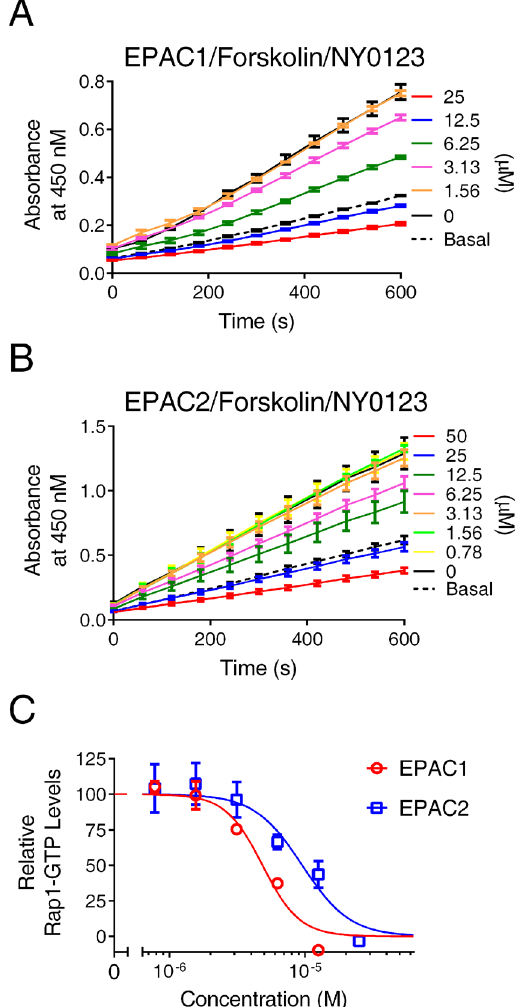
Figure 5. Dose-dependent inhibition of forskolin-induced cellular EPAC1 and EPAC2 activation by NY-0123. ( A ) Time course of EPAC1-mediated Rap1 activation induced by 1 µ M Forskolin in the presence of various concentrations of NY-0123. ( B ) Time course of EPAC2-mediated Rap1 activation induced by 1 µ M Forskolin in the presence of various concentrations of NY-0123. ( C ) Relative Rap1-GTP levels induced by 1 µ M forskolin as a function of NY-0123 concentration in HEK293 cells overexpressing EPAC1or EPAC2, respectively. Data are presented as Means ± SD, n =